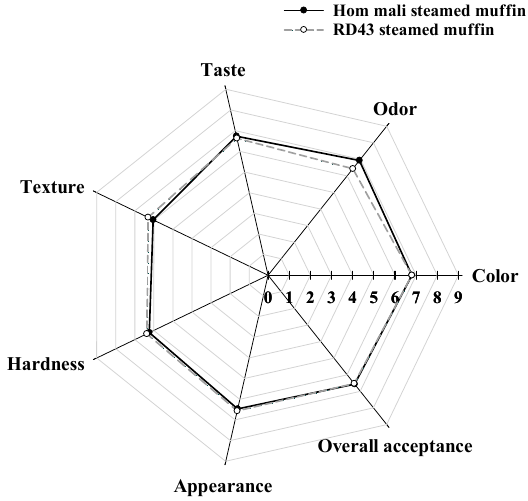
Figure 7. Sensory analysis of Hom Mali and RD43 rice steamed muffin. Data are expressed as the mean.